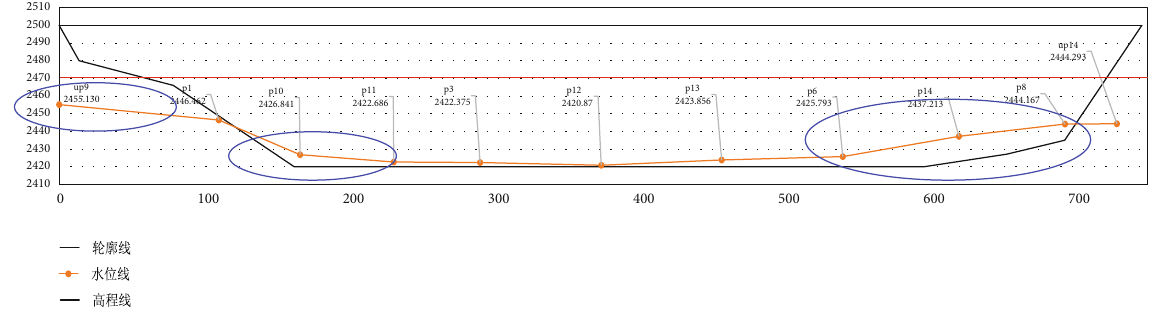
Figure 17: Monitoring value of lateral osmotic pressure